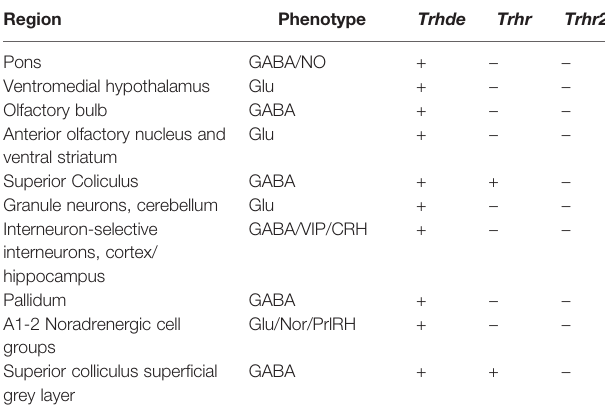
TABLE 1 | Cells types along the mouse central and peripheral nervous system with the highest expression of Trhde , and relative expression of Trhr and Trhr2